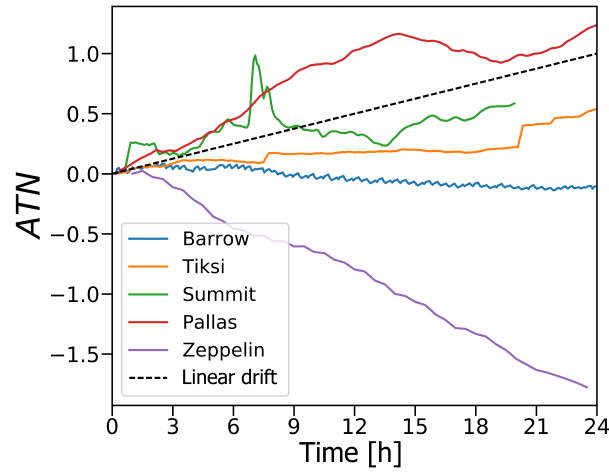
Figure 3. Drift in ATN during measurements of particle-free air at five arctic stations. The linear drift shown in the figure corresponds to a σ 0 value of 0.07Mm − 1 when Q = 5Lmin − 1 , A = 0.5cm 2 , and the drift in ATN is 1 in 24h. In the figure, ATN has been forced to begin at 0 for easier comparison; see Appendix A for greater